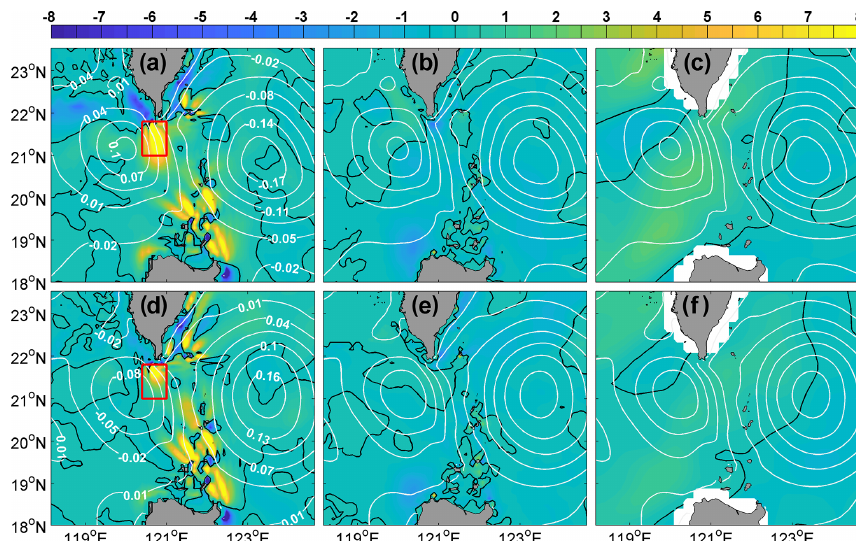
Figure 15. BT based on HYCOM data (10 − 5 m 3 s − 3 ) represented by colors (a, d) ; BC based on HYCOM data (10 − 5 m 3 s − 3 ) represented by colors (b, e) ; WW based on CMEMS surface velocity data and NCDC wind data (10 − 5 m 3 s − 3 ) represented by colors (c, f) . Red box borders 21–21.8 ◦ N, 120.4–121 ◦ E. White contours represent SSHA contours of. Panels (a) , (b) , and (c) plot CE (and d , e , and f plot AE) mode of counter-rotating eddy pair in